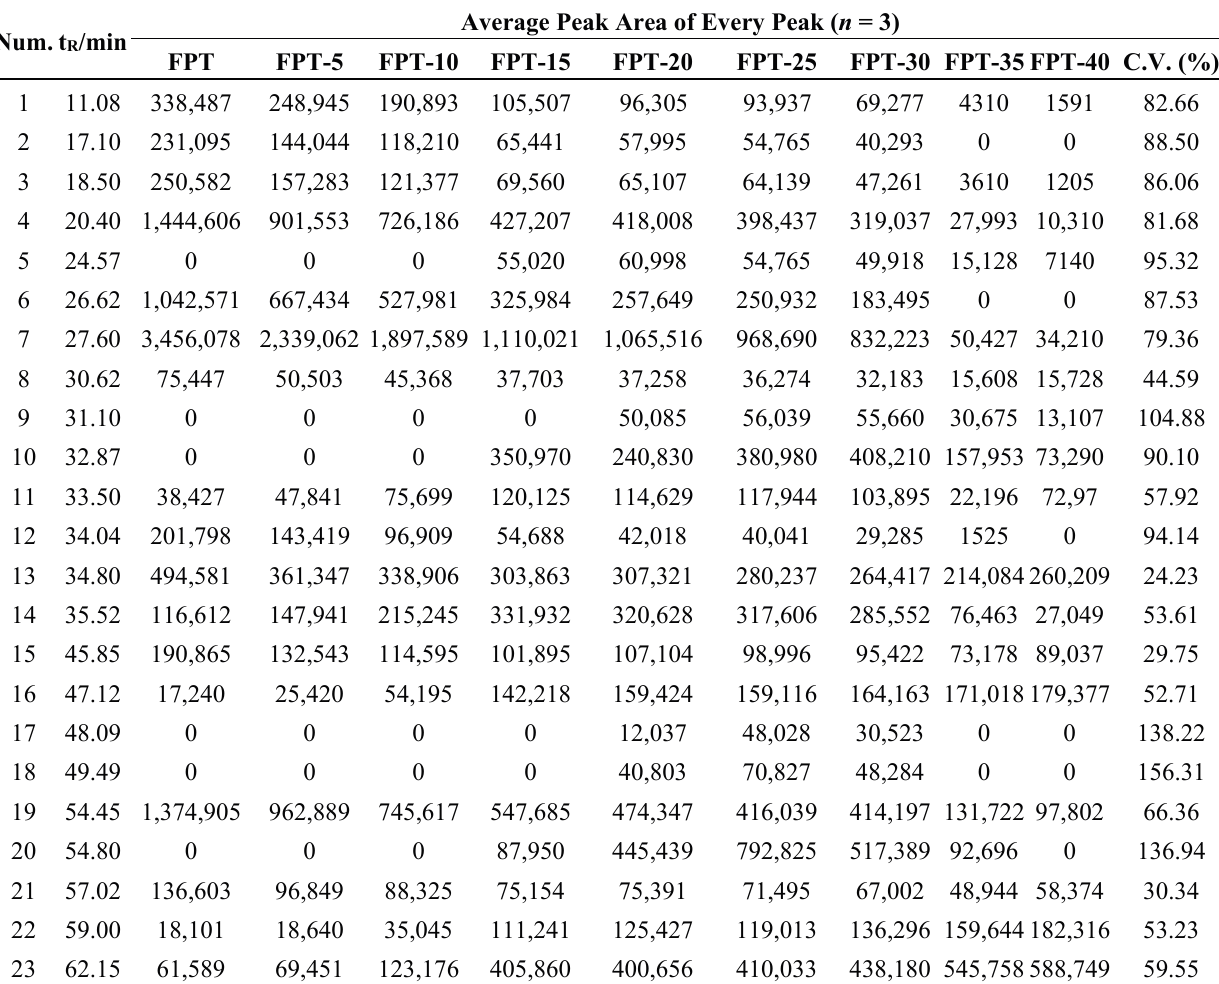
Table 2. Relative peak area of each peak of